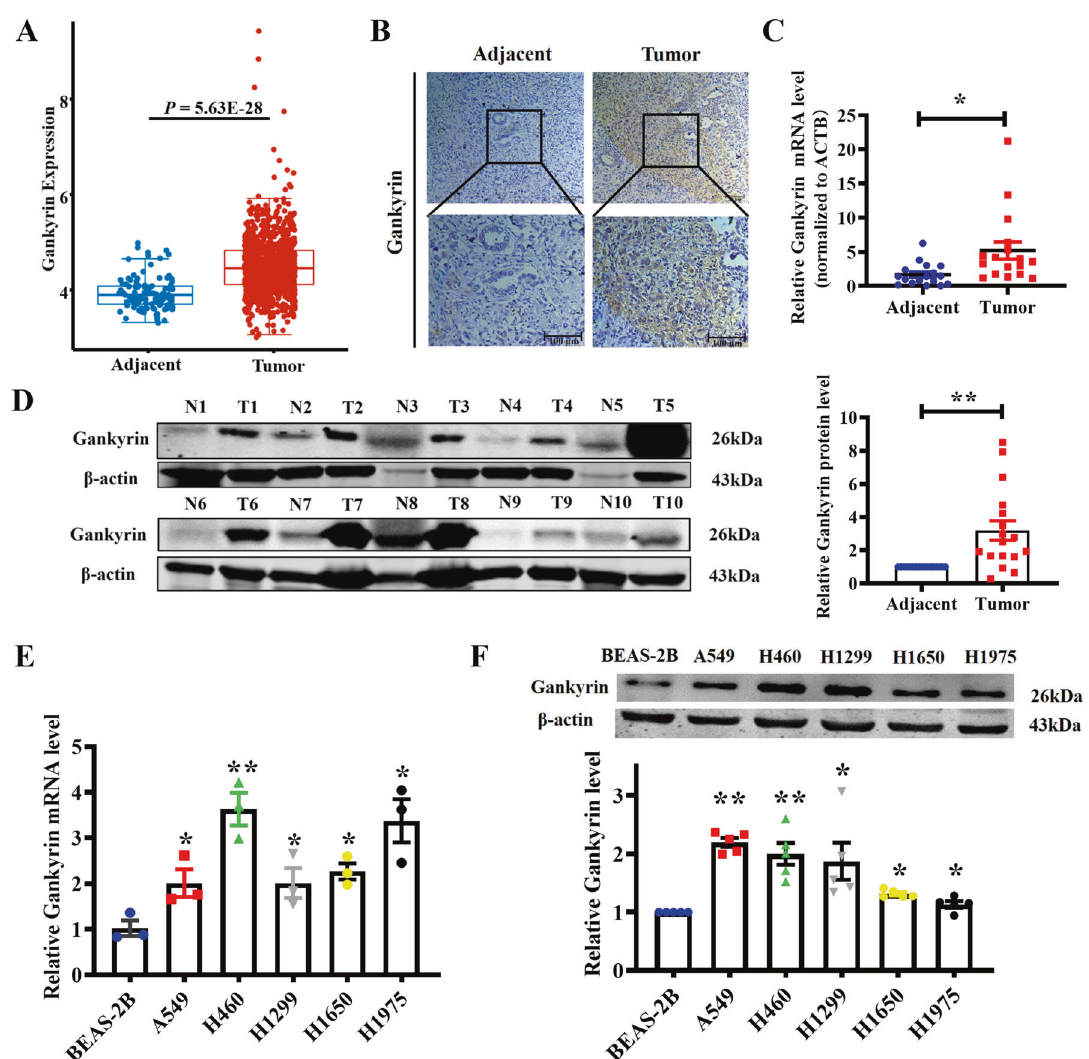
Fig. 1 Expression of Gankyrin is upregulated in NSCLC. A The expression of Gankyrin in NSCLC tissues and adjacent normal tissues in TCGA dataset ( P = 5.63E-28, Student ’ s t -test). B Representative images of Gankyrin immunohistochemistry staining in NSCLC and adjacent normal tissues (Scale bars: 100 μ m). C qRT-PCR was performed to assess the mRNA level of Gankyrin in tumor tissues and adjacent tissues ( n = 17, * P < 0.05). D Gankyrin protein levels in tumor tissues and adjacent tissues evaluated through western blotting. T: tumors; N: adjacent normal tissues ( n = 17, ** P < 0.01). E The mRNA level of Gankyrin in BEAS-2B, A549, H460, H1299, H1650, and H1975 cells assessed using qRT-PCR ( n = 3, * P < 0.05, ** P < 0.01 vs . BEAS-2B). F Western blotting analysis of Gankyrin expression in BEAS-2B, A549, H460, H1299, H1650 and H1975 cells ( n = 5, * P < 0.05, ** P < 0.01 vs .